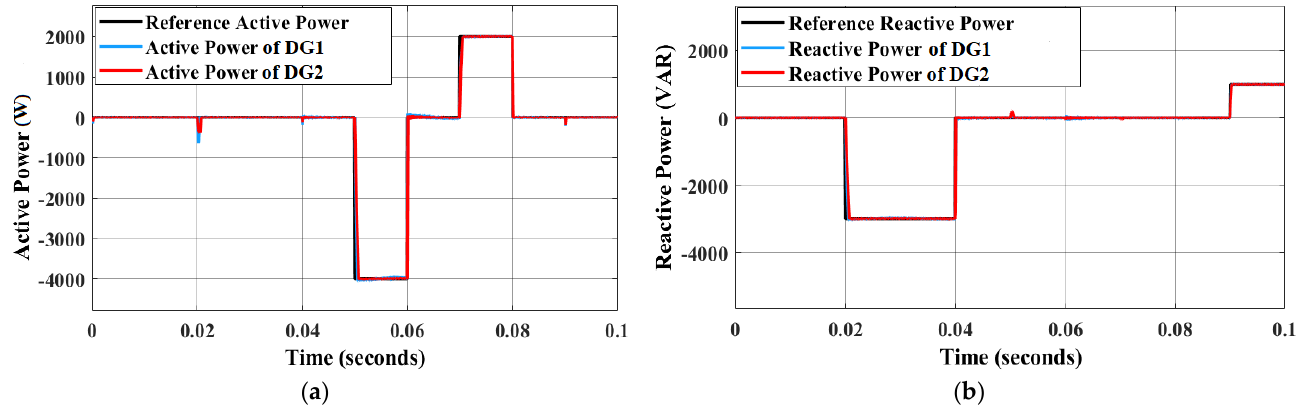
Figure 10. Individual DG power flow control using MPC.